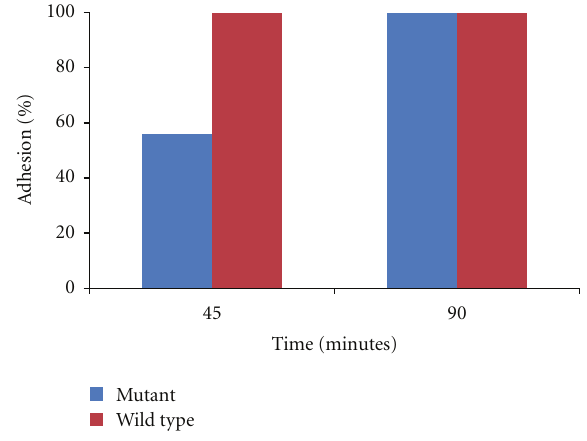
Figure 2: Adhesion to human epithelial cells. Strains were incu- bated with cell line HT-29 for 45 and 90 minutes. After washing away, any nonadherentcells wells were overlaid with molten PDA. Adhesion to epithelial cells was assessed by counting the number of colonies present on the microtiters plates after 24h and comparing to control plates. Adhesion was expressed as a percentage of the original inoculums. As can be seen, the mutant exhibited a significant delay in adhesion after 45min ( P < .